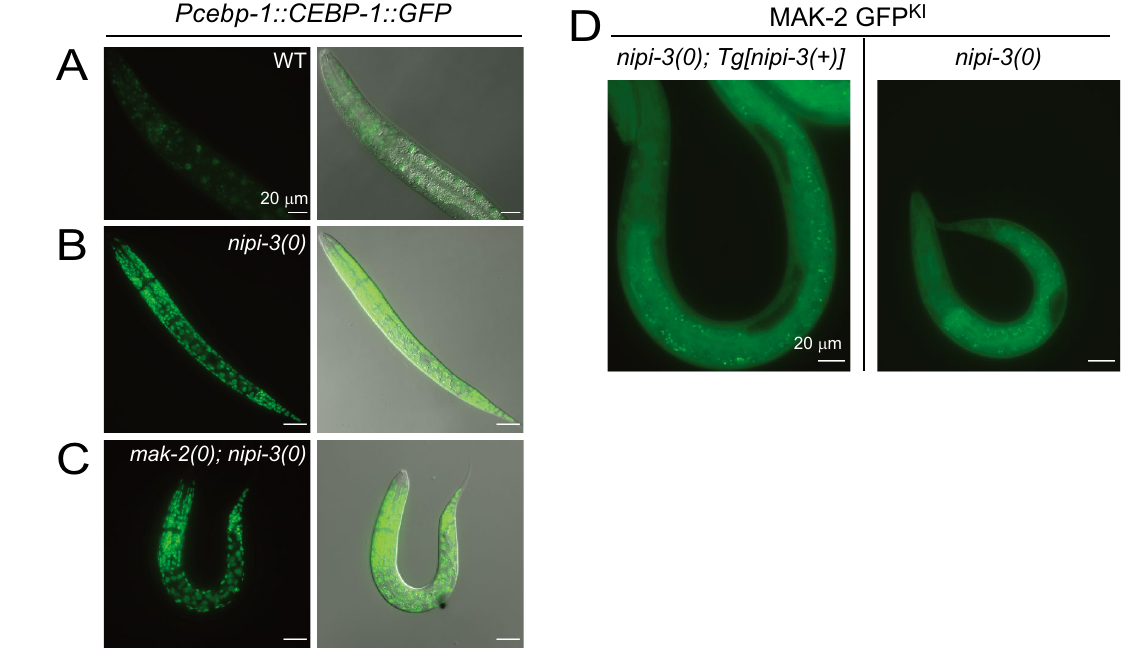
Figure 6. mak-2 is not required for upregulation of CEBP-1 in response to nipi-3(0) and MAK-2 localization is unaltered by nipi-3(0). ( A – C ) Fluorescent and DIC images of CEBP-1::GFP under the cebp-1 promoter as a multicopy integrated reporter ( wgIs593 ) in animals 24 h post hatch. Scale bar = 20 µm. CEBP-1::GFP is expressed at low levels in WT background, while highly upregulated in nipi-3(ju1293) or in mak-2(tm2927); nipi-3(ju1293) . ( D ) Fluorescence images of MAK-2 GFP KI ( ju1851) in animals 24 h post hatch. The left column of image is in the background of nipi-3(0); Tg[nipi-3( + )] and the right column of image is in the background of nipi-3(0). GFP is expressed throughout the animal but is noticeably absent from the gonad. Scale bars = 20 µm.